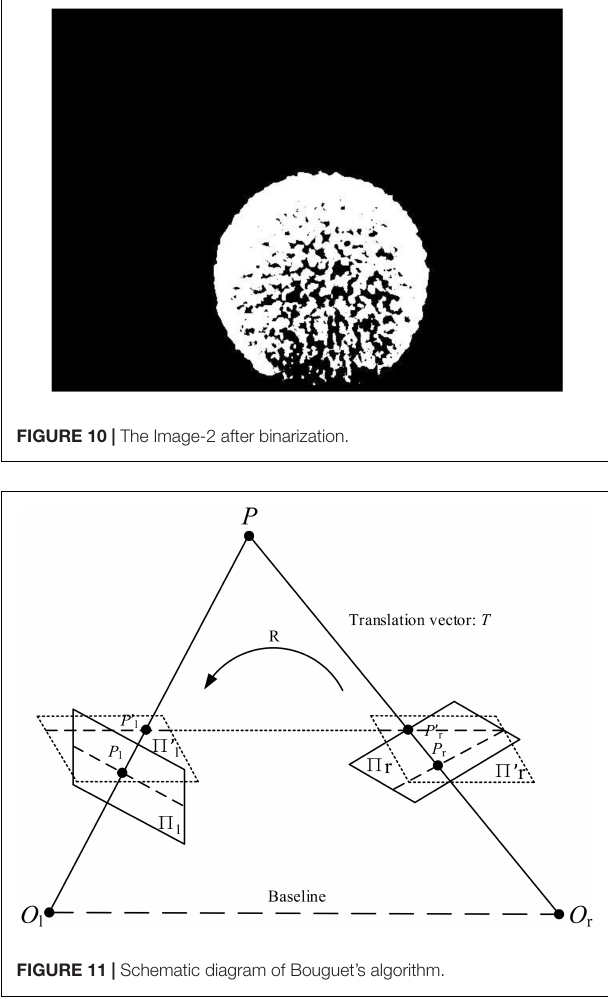
FIGURE 11 | Schematic diagram of Bouguet’s